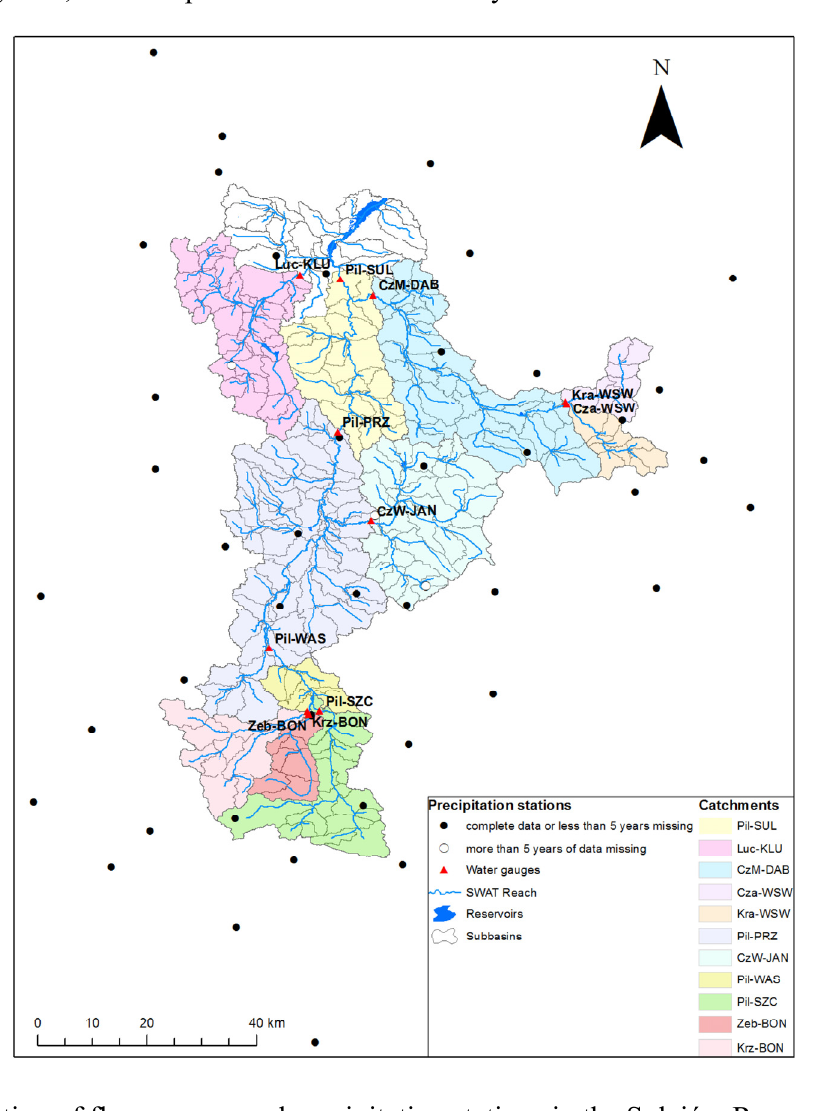
Figure 2. Location of flow gauges and precipitation stations in the Sulejów Reservoir